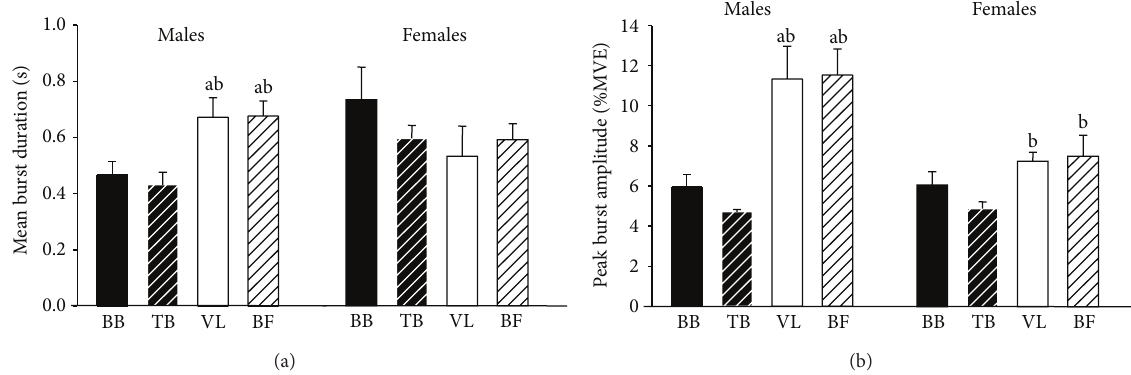
Figure 3: Muscle effect on mean burst duration and peak burst amplitude for old adults. (a) Mean burst duration; (b) peak burst amplitude. BB: biceps brachii; TB: triceps brachii; VL: vastus lateralis; BF: biceps femoris; sec: seconds; %: percentage; MVE: maximal voluntary exertion. a Significantly different from BB; b significantly different from